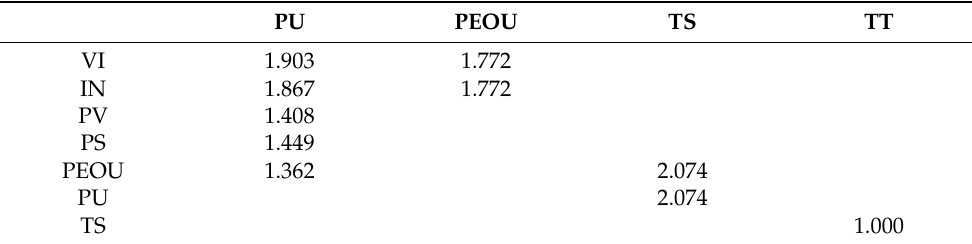
Table 5. Collinearity Test